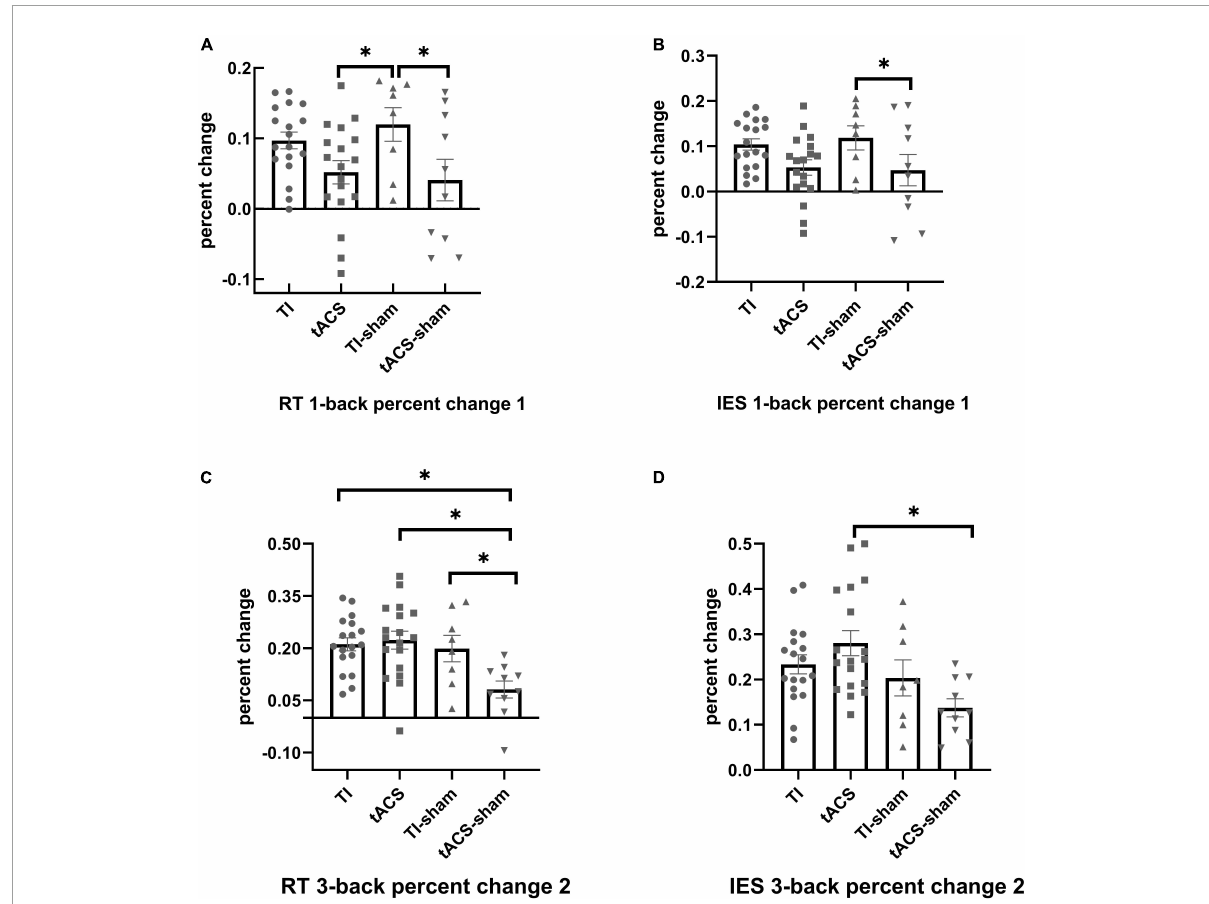
FIGURE4 The effects of stimulation on the performance of N-back task. For RT, significantly greater percent changes were induced in the TI-sham group in the 1-back compared to tACS-sham and tACS (percent change 1) (A) ; significantly greater percent changes were induced in TI, TI-sham, and tACS in the 3-back task compared to tACS-sham (percent change 2) (C) . For IES, significantly greater percent changes were induced in TI-sham in the 1-back task compared to tACS-sham (percent change 1) (B) ; significantly greater percent changes were induced in tACS in the 3-back task compared to tACS-sham (percent change 2) (D) . Error bars represent SEM. * p < 0.05. The larger the positive percent change in RT and IES, the better the improvement in working memory. TI, temporal interference; tACS, transcranial alternating current stimulation; RT, reaction time; IES, inverse efficiency score. Percent change 1 = [(pre-stimulation values)–(during-stimulation values)]/(pre-stimulation values); Percent change 2 = [(pre-stimulation values)–(post-stimulation values)]/(pre-stimulation values); SEM, standard